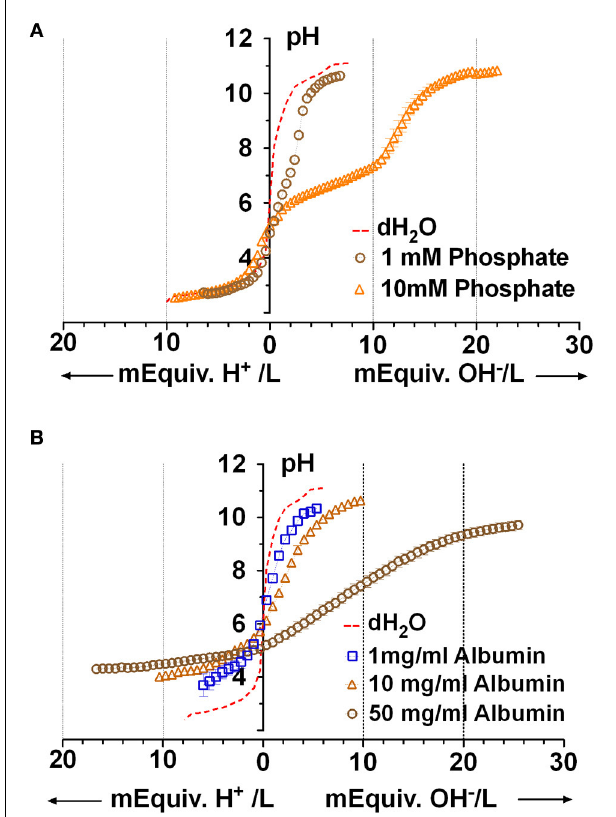
FIGURE 4 | Evidence for a non-bicarbonate buffer in Calu-3 fluid. (A) Forward and back titration curves for Calu-3 secretions. Samples were equilibrated with air for 1h at pH < 4 after the forward titration to drive off CO 2 . (B) Buffer capacity as a function of pH calculated from the forward ( (cid:4) ) and back ( (cid:2) ) titrations. Means ± SD; n = 3–5.